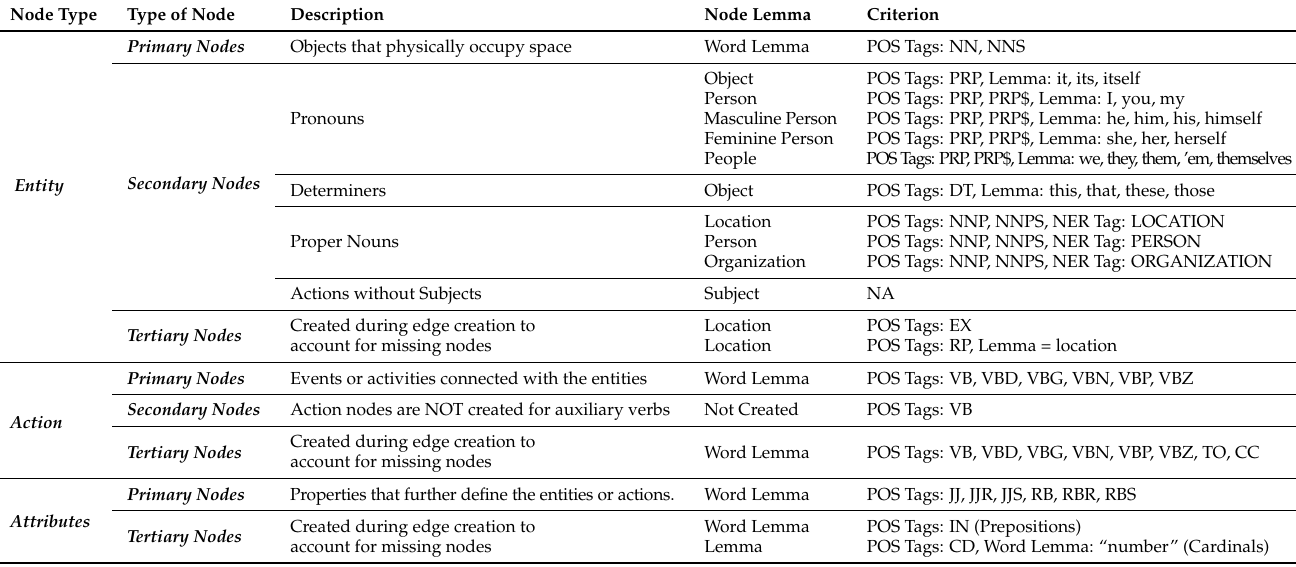
Table 1. A summary of the criteria for creating nodes from dependency